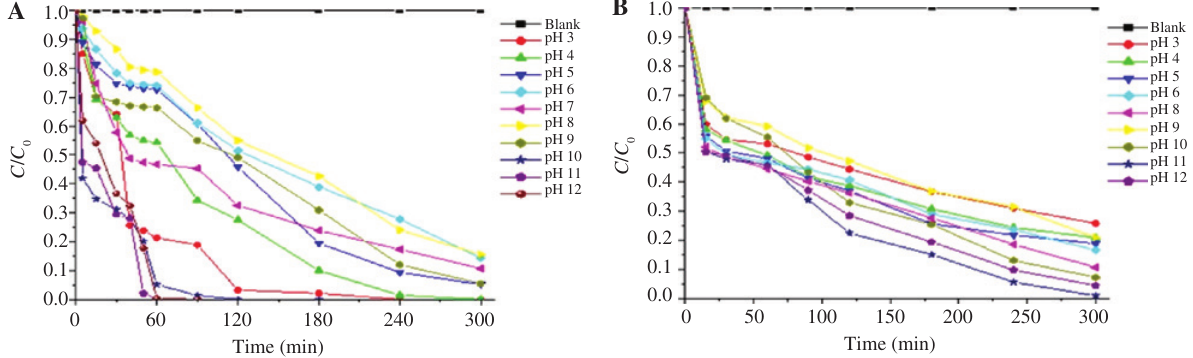
Figure 10: Effect of pH on the decolorization of (A) reactive black 5 and (B) methylene blue dyes.